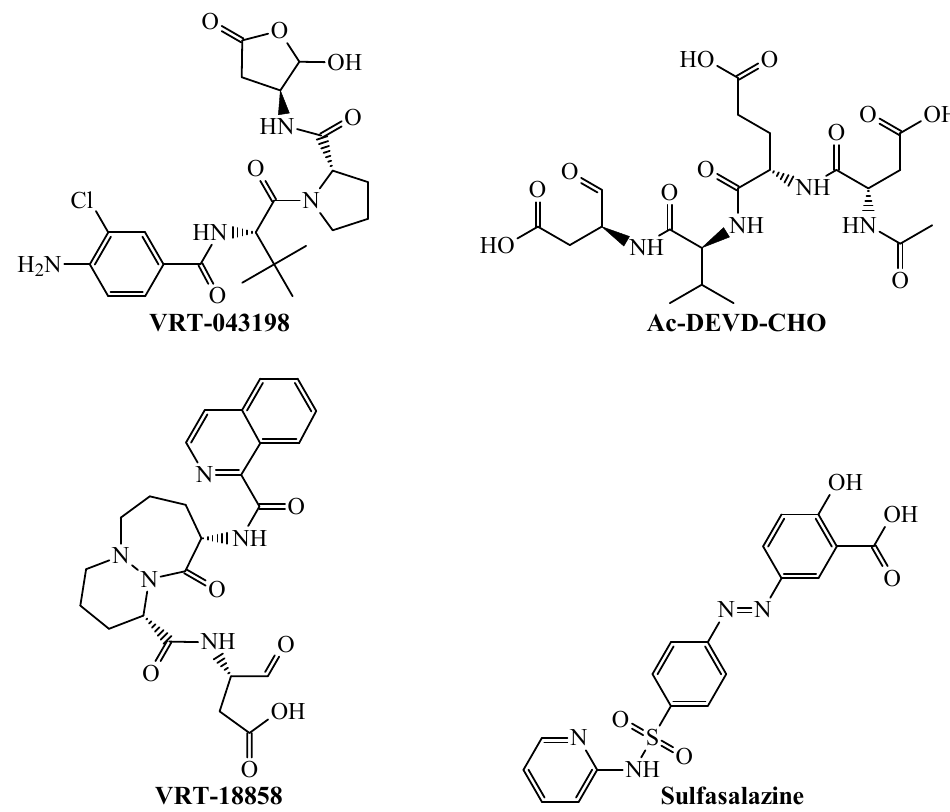
Figure 3. Chemical structures of molecules accurately predicted by the mtc-QSAR-MLP model as caspase-1 inhibitors.